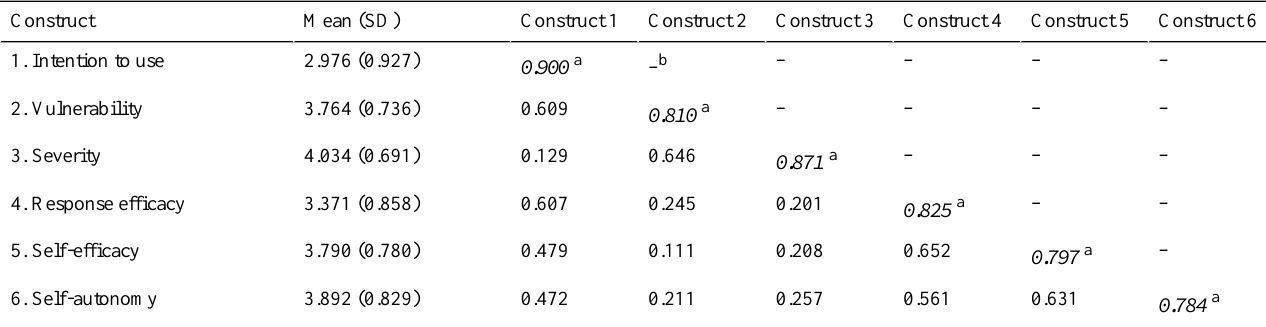
Table 6. Matrix of latent constructs’correlations.